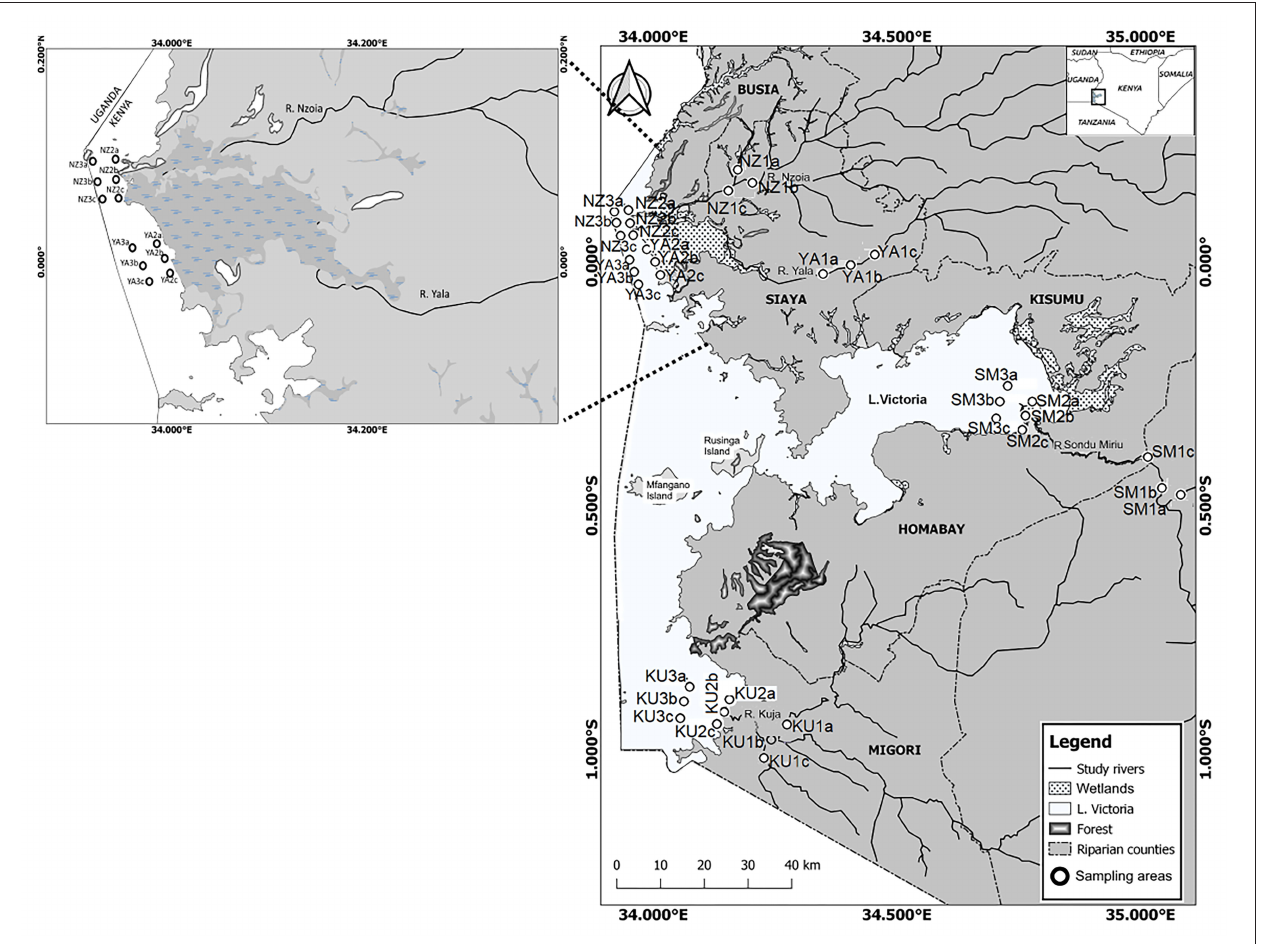
FIGURE 1 | Location of the study sites within the stations of (a) River Kuja (KU), (b) River Sondu-Miriu (SM), (c) River Yala (YA), and (d) River Nzoia (NZ). Sampling sites with at least three replicates as representative of microhabitats included River Kuja: KU1a, b, c—River Kuja upstream channel; KU2a, b, c—Kuja river mouth before discharge; KU3a, b, c—Kuja river mouth after discharge. Sondu–Miriu: SM1a, b, c—River Sondu-Miriu upstream; SM2a, b, c—Sondu-Miriu river mouth before discharge; SM3a, b, c—Sondu-Miriu River mouth after discharge. River Yala: YA1a, b, c—River Yala upstream; YA2a, b, c—Yala river mouth before discharge, YA3a, b, c—Yala river mouth after discharge. River Nzoia: NZ1a, b, c—River Nzoia upstream, NZ2a, b, c—Nzoia river mouth before discharge, NZ3a, b, c—Nzoia river mouth after discharge. The labels (a–d) represents sampled replicates of each